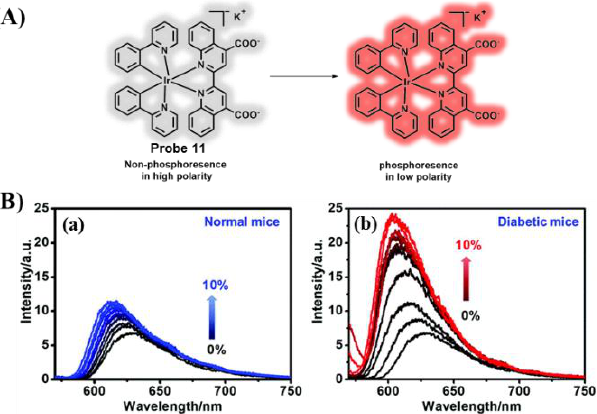
Figure 9. ( A ) Imaging mechanism of probe 11 ; ( Ba ) phosphorescence spectra of probe 11 in 0–10% blood solution of normal mice; ( Bb ) phosphorescence spectra of probe 11 in 0 − 10% blood solution of diabetic mice. Conditions: λ ex = 405 nm, λ em = 570 − 750 nm. Adapted from Reference [72]. Copyright 2017, the Royal Society of Chemistry.